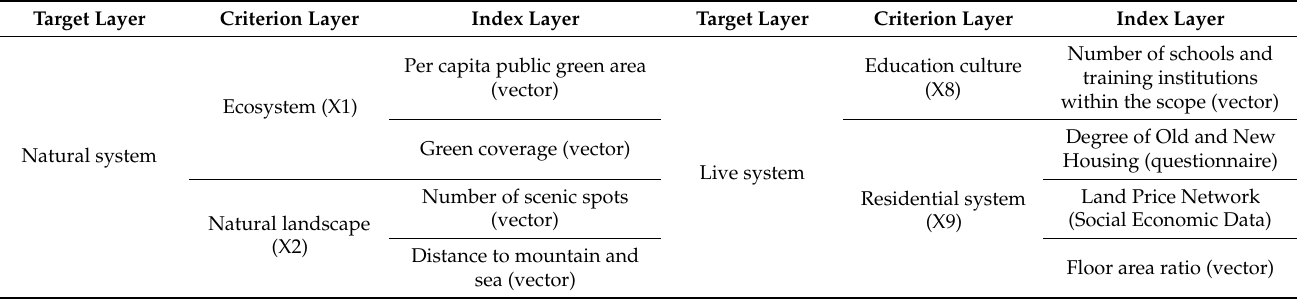
Table 2. Comprehensive index system of human settlements systems in Dalian city